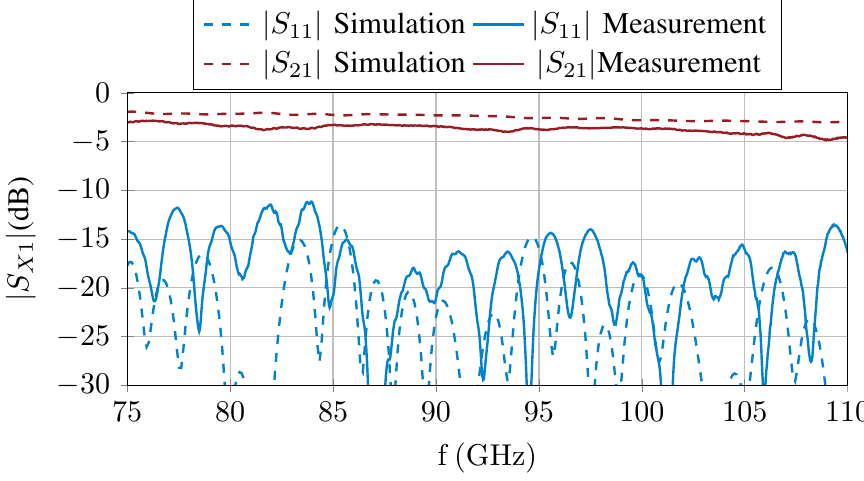
Figure 17. Measured and simulated S-parameter for orthogonal LC orientation of the DIL phase shifter. A differential phase shift from 150° to 350° was obtained with a rectangular AC bias voltage of V pp = 300 V with 1 kHz, as shown in Figure 18. However, there is a difference of around 85° between measurement and simulation. As described in detail in [23], an air gap between ground plane and DIL is the reason for this effect. Furthermore, the previously mentioned electrode system can not use the whole anisotropy range of the LC as in the simulations. As a consequence of the lower differential phase shift, the FoM is lower as predicted and is ranging between 50 °/dB to 80 °/dB. The maximum steering efficiency is τ ϕ = 16.7